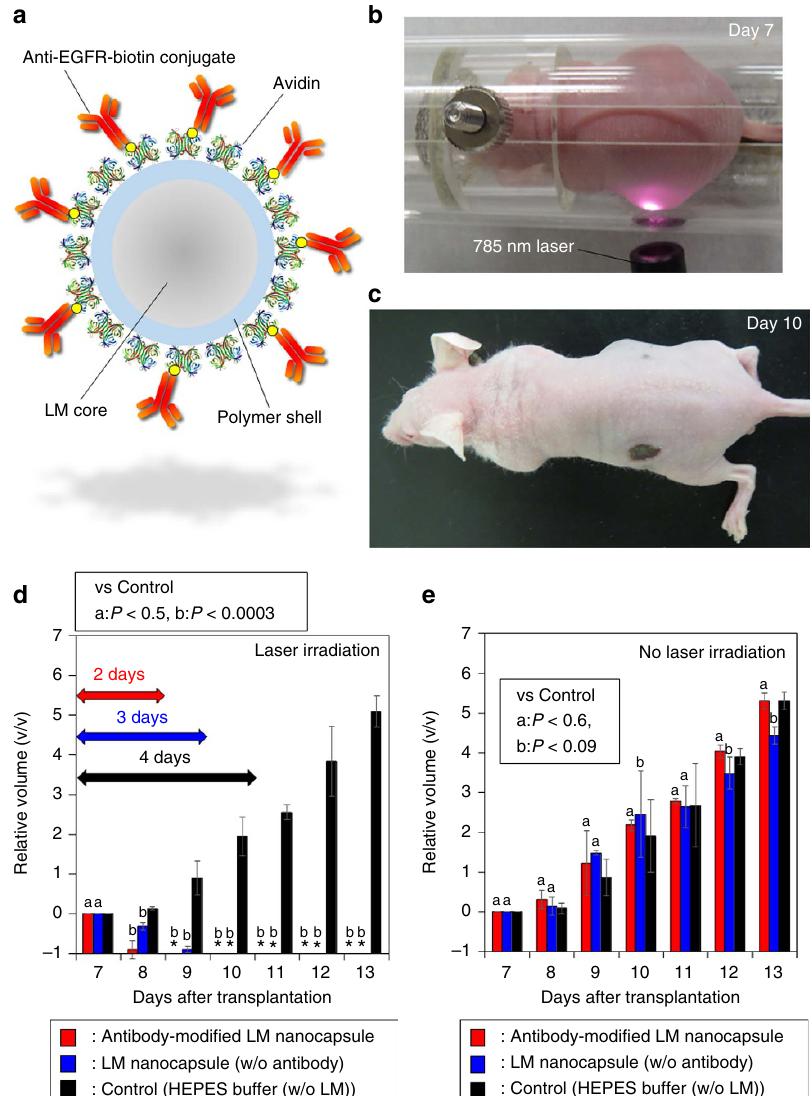
Figure 8 | Photodynamic and hyperthermia destruction of tumours in vivo . ( a ) Schematic illustration of antibody-functionalized LM nanocapsules for target tumour elimination. ( b ) A mouse with large tumours on its left and right side back 7 days after tumour cell transplantation (day 7). The tumour on the left side back is being irradiated with 785nm laser. ( c ) A mouse after 3 days of treatment (day 10) with Anti-EGFR-Biotin-Avidin-DSPE-PEG 2000 - Amine-DC(8,9)PC-LM and laser irradiation of the tumour on its left side back. ( d ) Relative volumes of tumours on the laser-induced left side back. HEPES dispersions of Anti-EGFR-Biotin-Avidin-DSPE-PEG 2000 -Amine-DC(8,9)PC-LM (red bars) or HEPES dispersions of Avidin-DSPE-PEG 2000 -Amine- DC(8,9)PC-LM (blue bars), or HEPES (black bars) were intratumourally injected and treated with 785nm laser. Red, blue, and black arrows represent laser irradiation periods for HEPES dispersions of Anti-EGFR-Biotin-Avidin-DSPE-PEG 2000 -Amine-DC(8,9)PC-LM-, HEPES dispersions of Avidin-DSPE-PEG 2000 - Amine-DC(8,9)PC-LM-, and HEPES-injected mice, respectively. *N.D.: not determined because tumours were completely disappeared. Error bars